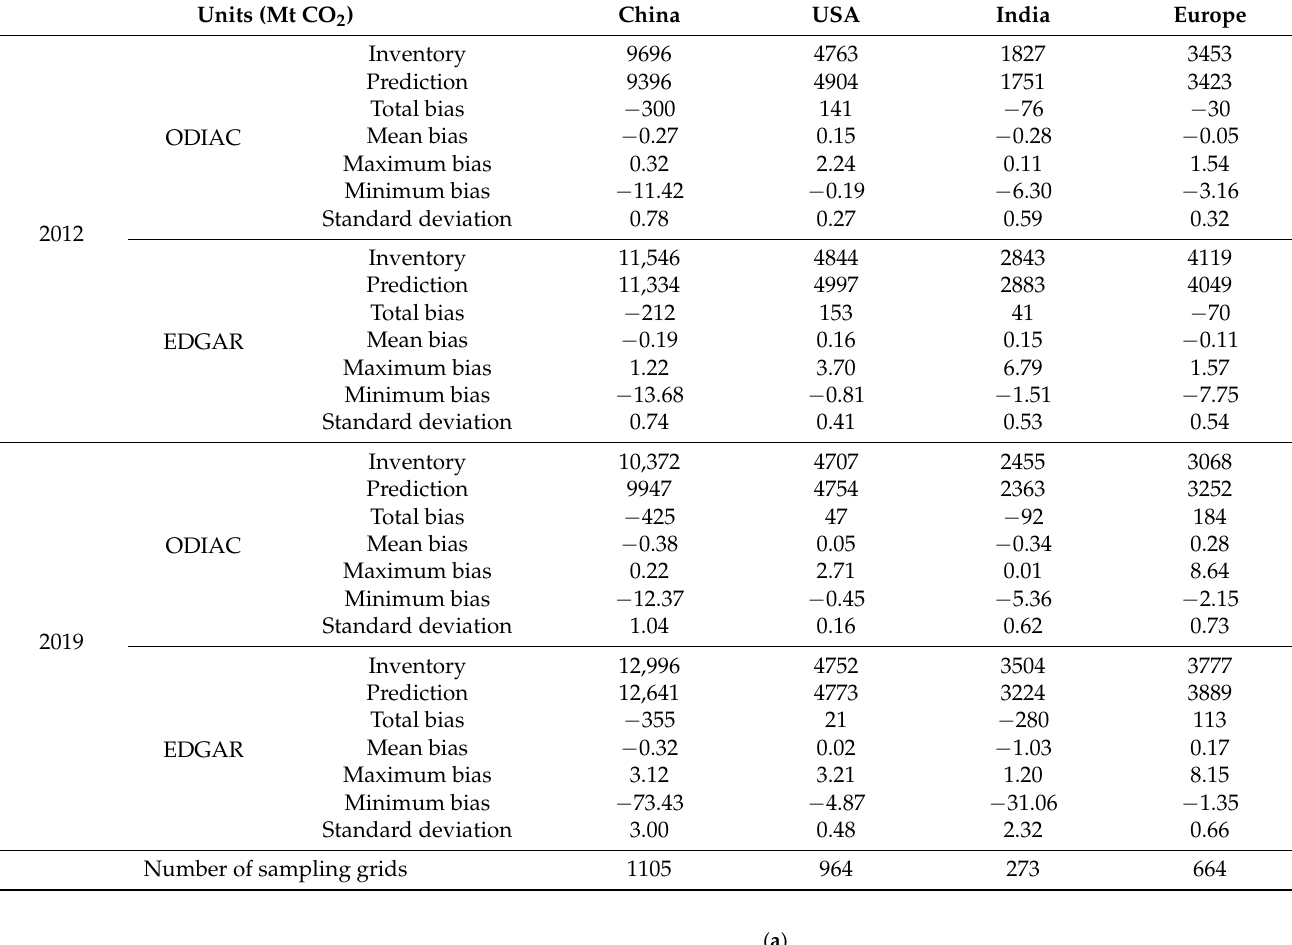
Table A1. Statistics of inventory emissions results in different regions.